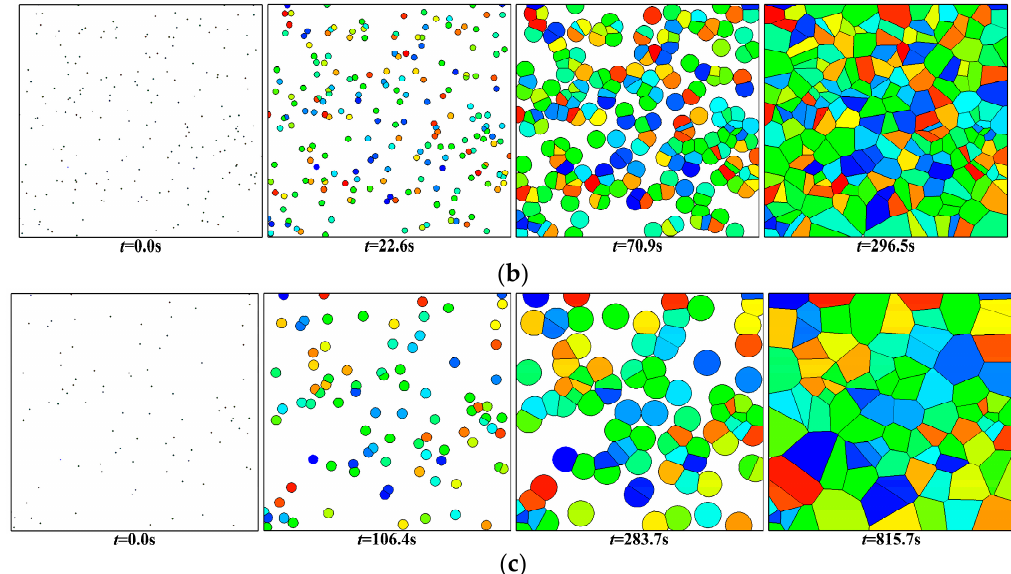
Figure 7. Evolution of crystal morphology under different temperatures: ( a ) T = 121.85 °C; ( b ) T = 126.85 °C; and ( c ) T = 131.85 °C.